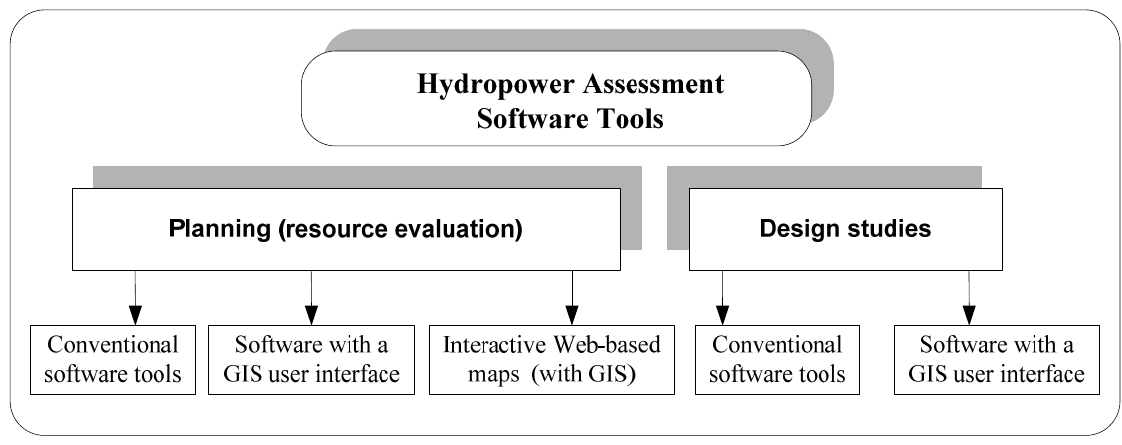
Figure 1. Software tools used for hydropower